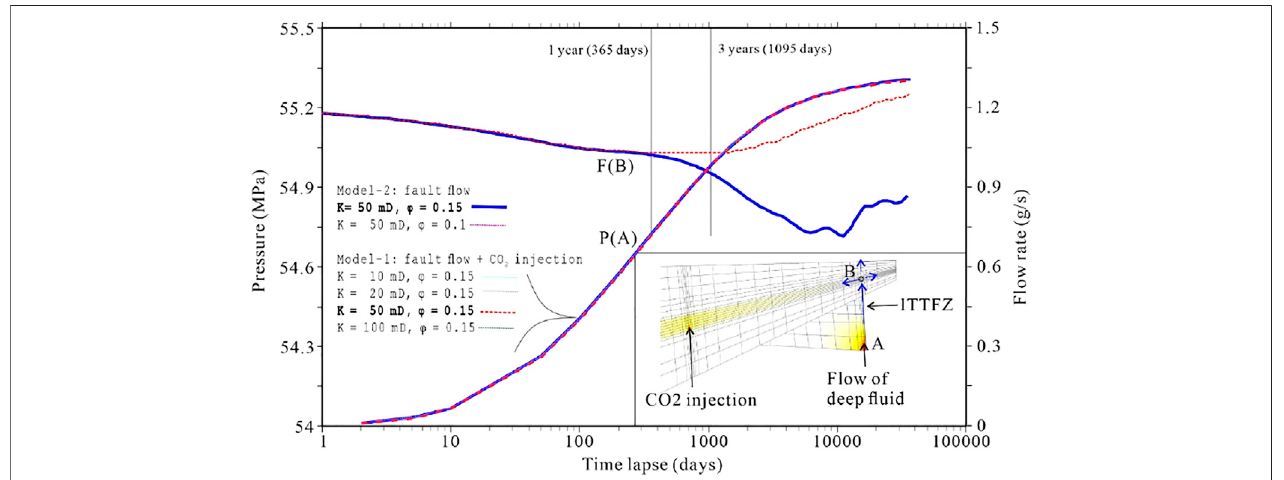
FIGURE 5 | Pressure and fl ow rate at key points. A: Injection point within the fault at a depth of 6 km. B: Intersection of the fault and the Moebetsu injection layer. The results of different permeability and porosity for the Moebetsu formation consistently show that CO 2 injection has no effect on fl uid pressure at the deep part of the fault event after 100 consecutive years of